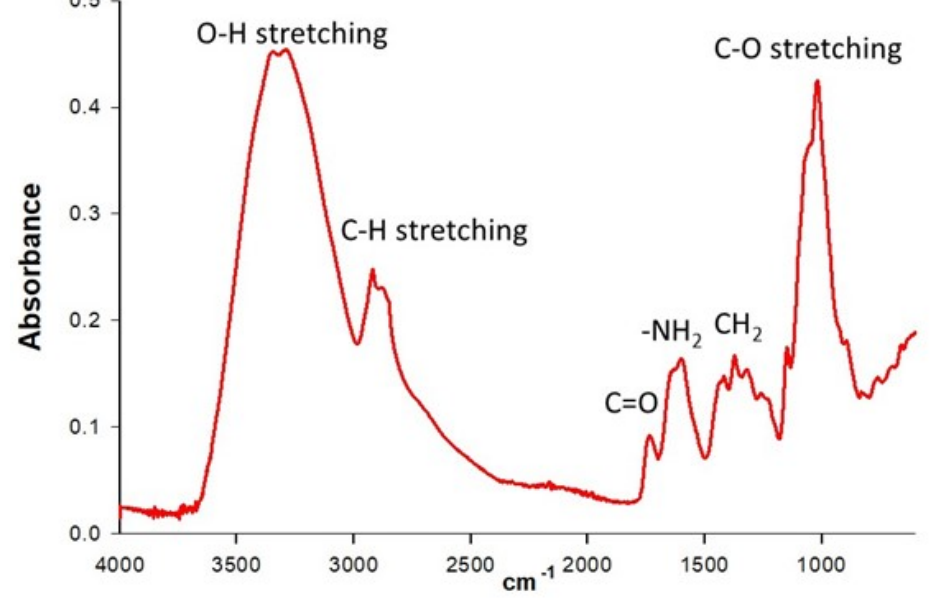
Figure 3. FT-IR spectrum corresponding to the chitosan sample.